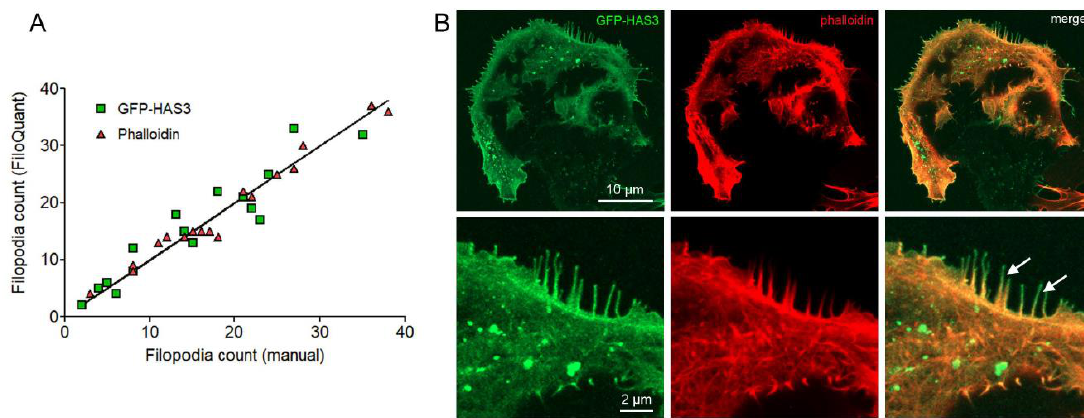
Figure 2. Precision in filopodia detection with EGFP-HAS3 and phalloidin signal in fixed cells. ( A ) The amount of filopodia detected with FiloQuant analysis is plotted against the manually annotated filopodia number for each cell edge by using EGFP-HAS3 signal (green squares, R 2 = 0.8964) and phalloidin signal (red inverted triangles, R 2 = 0.9717). ( B ) Images illustrating EGFP-HAS3 signal and phalloidin signal; arrows in (B) point filopodia in the edge of MCF-7 cell expressing GFP-HAS3 ( n = 16 cells for both groups).